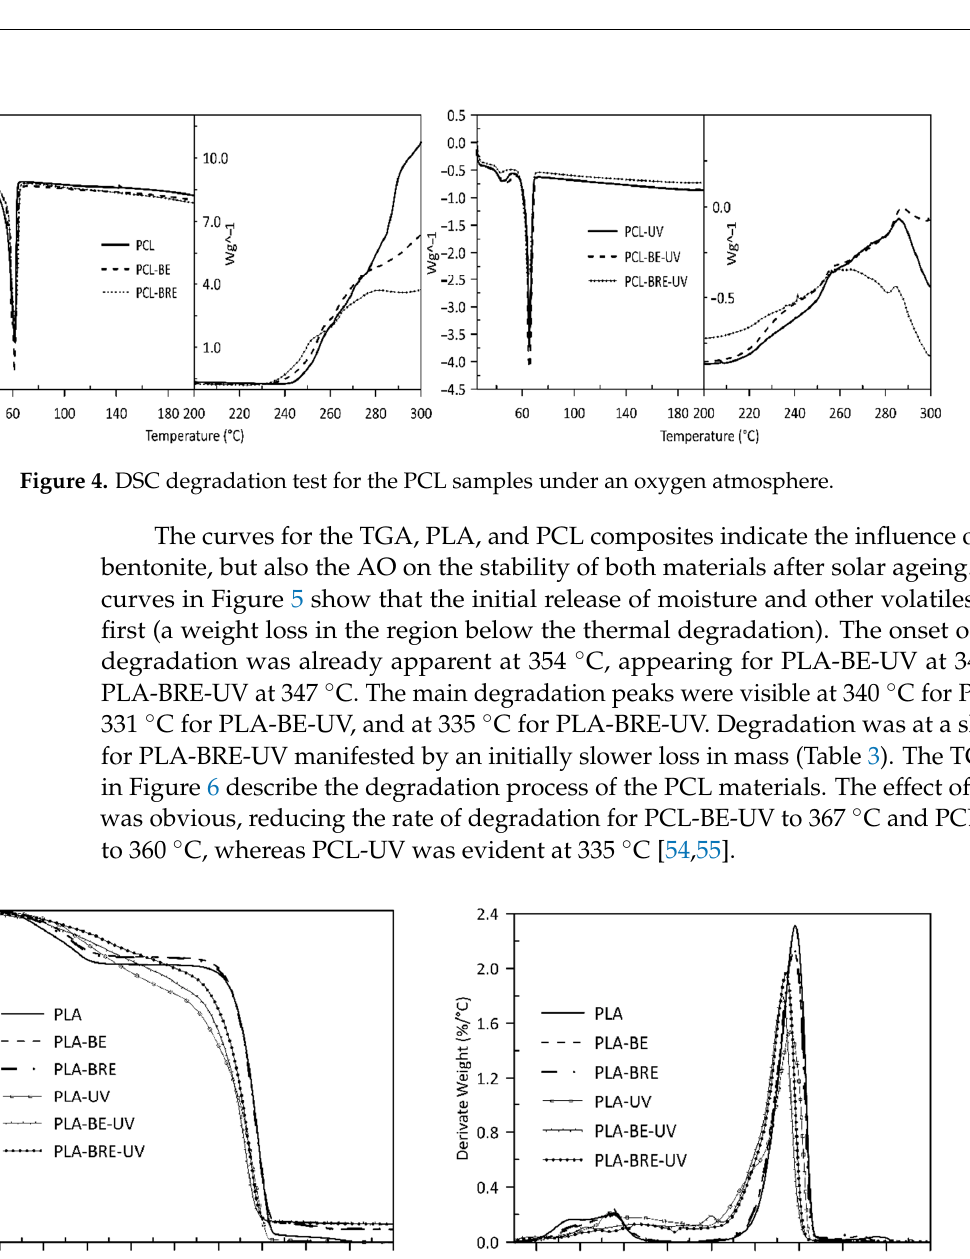
Figure 5. Thermogravimetric response of PLA bentonite with AO alongside the reference samples.